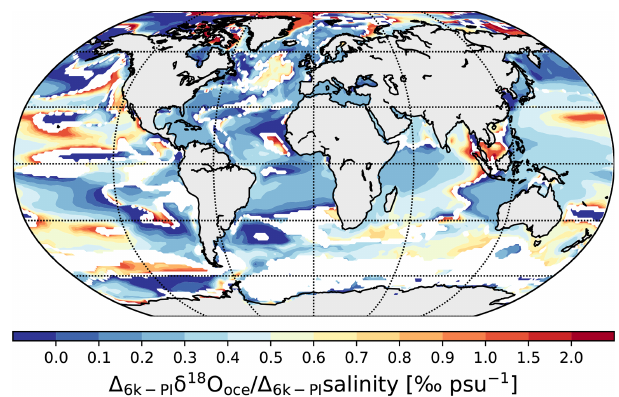
Figure 13. Spatial distribution of calculated temporal 6k–PI δ 18 O oce –salinity gradients for oceanic grid cells in which the 6k–PI absolute change in salinity is at least